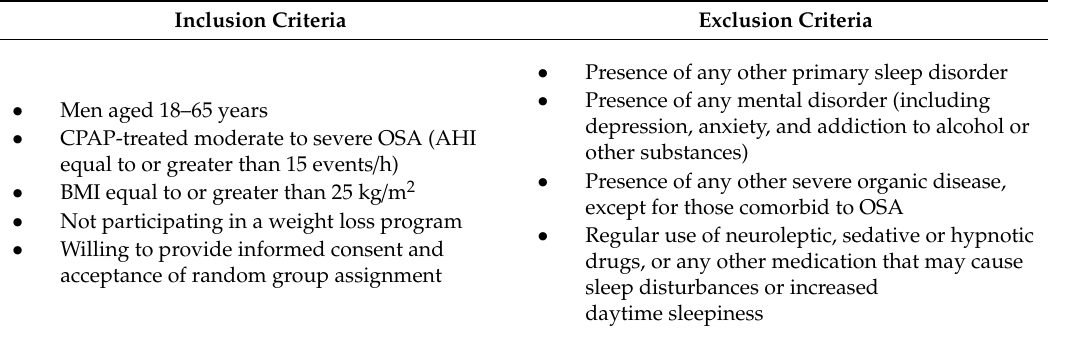
Table 1. Eligibility